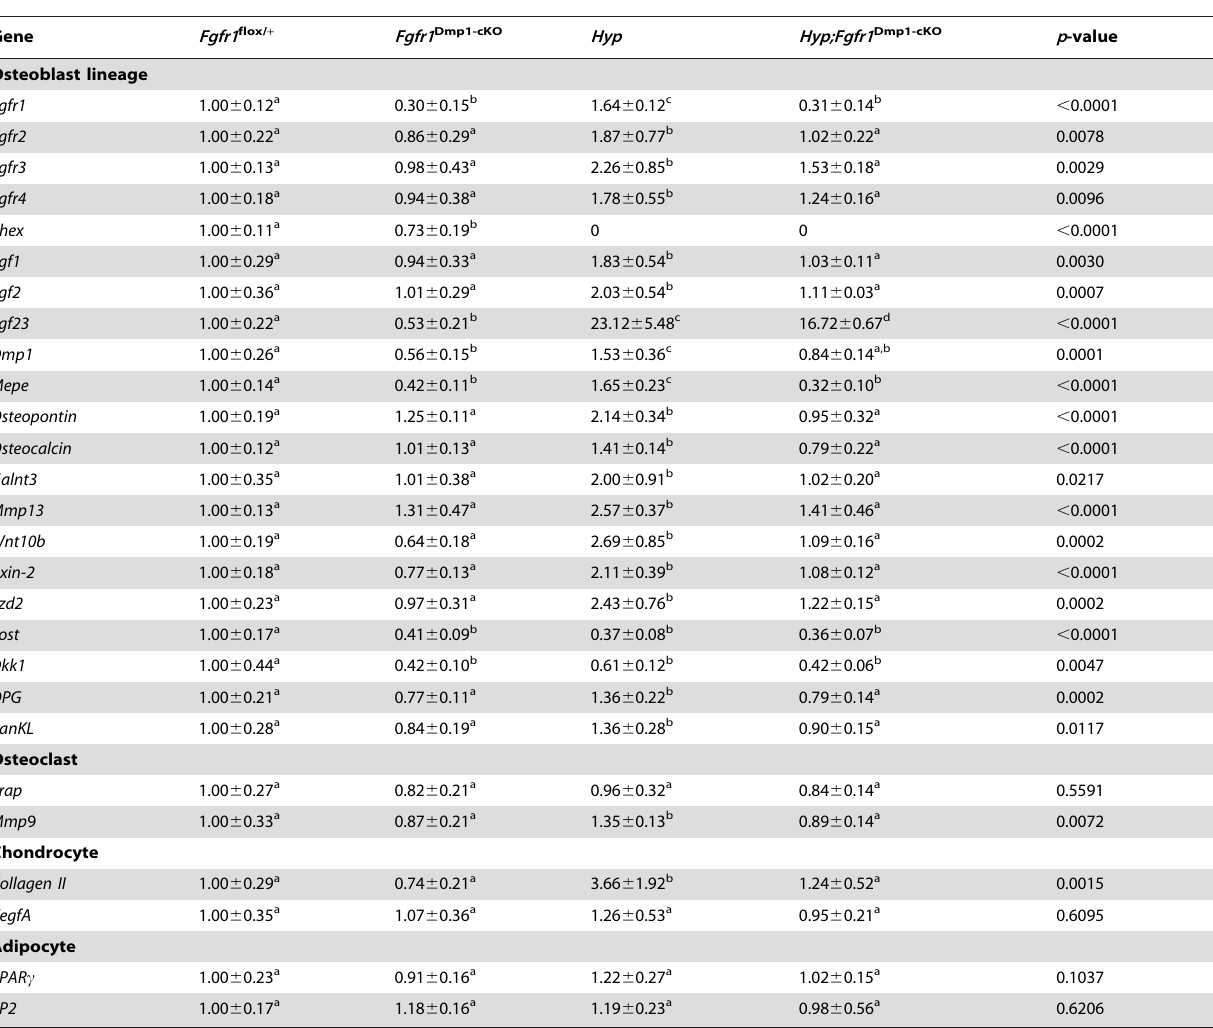
Table 1. Gene-expression profiles in bone in 6-week-old mice.